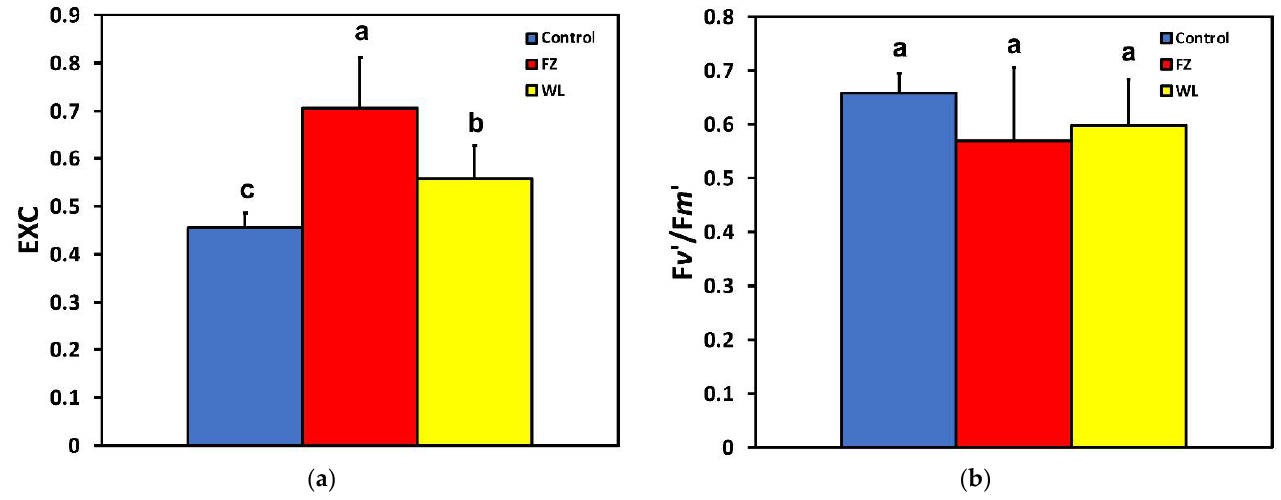
Figure 5. Changes in ( a ) the excess excitation energy (EXC) and ( b ) in the efficiency of open PSII reaction centers (F v ′/F m ′) at the whole leaflet level before feeding (control), at the feeding zone after feeding (FZ), and at the whole leaflet after feeding (WL). Error bars are standard deviations. Columns with different letters are statistically different ( p < 0.05).